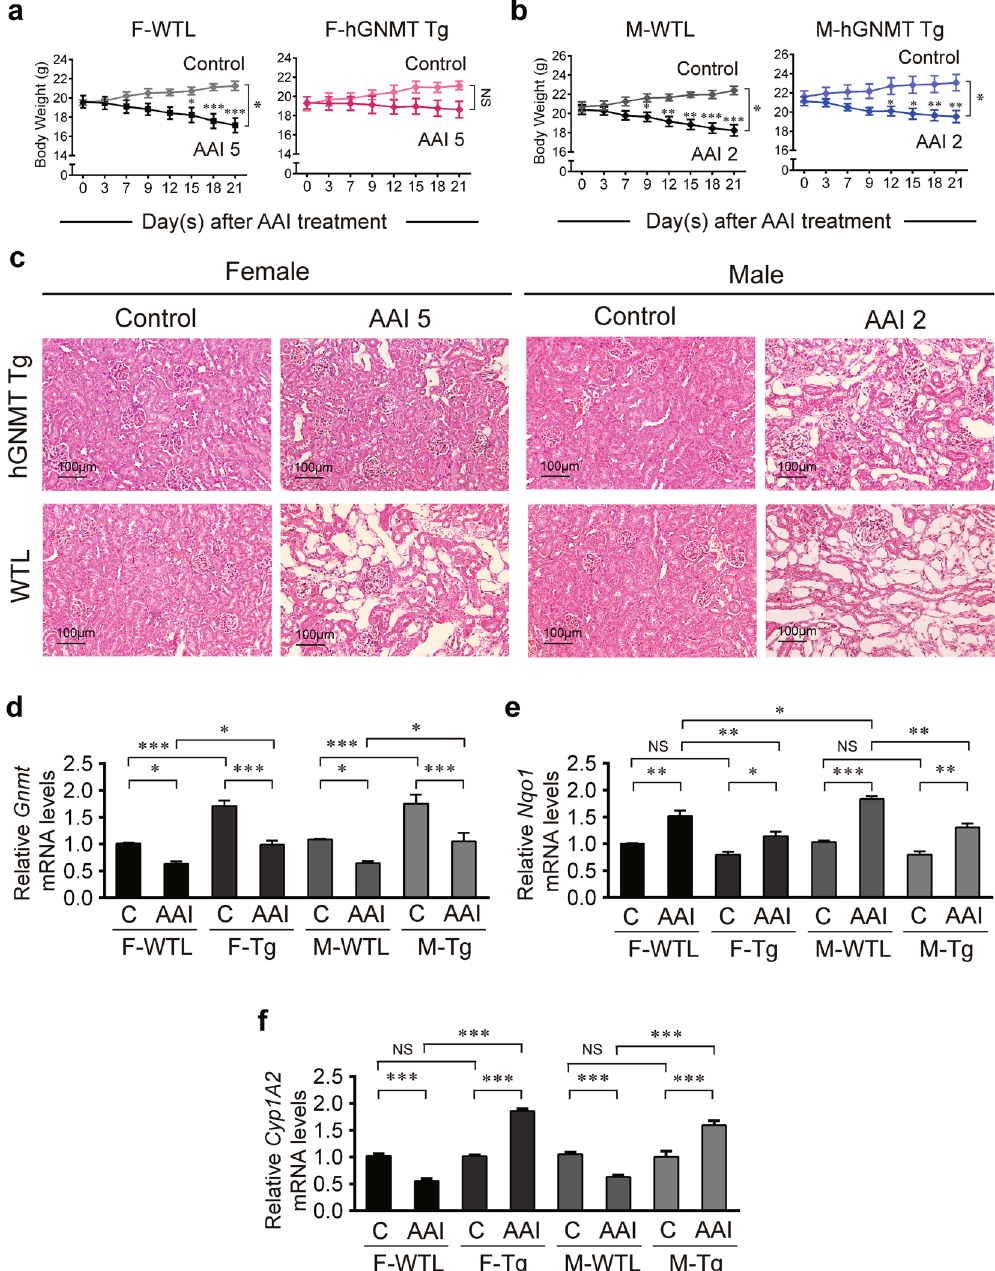
Figure 2. GNMT plays a protective role in AAI-induced renal damage. ( a,b ) Body weight of hGNMT transgenic (hGNMT Tg) mice and their wild-type littermates (WTL) intraperitoneally injected with 2 or 5 mg/kg BW/day AAI (AAI 2 or AAI 5) or corn oil (vehicle control), 5 days a week for 3 weeks. F: female; M: male. Values are presented as the mean ± SEM, n = 4. p -values were calculated by two-way ANOVA and Sidak’s multiple comparisons test. ( c ) Histological examination of the kidney morphology after AAI administration in GNMT Tg and WTL mice (hematoxylin and eosin stain, original magnification × 200). ( d–f ) mRNA level of Gnmt, Nqo1 and Cyp1A2 genes in the liver of AAI- or corn oil-treated GNMT Tg and WTL mice were determined by qPCR. Data were normalized to β -actin. C: vehicle control. Values are presented as the mean ± SEM, n = 5. p -values were calculated using Student’s t -test. * p < 0.05, ** p < 0.001, *** p ≤